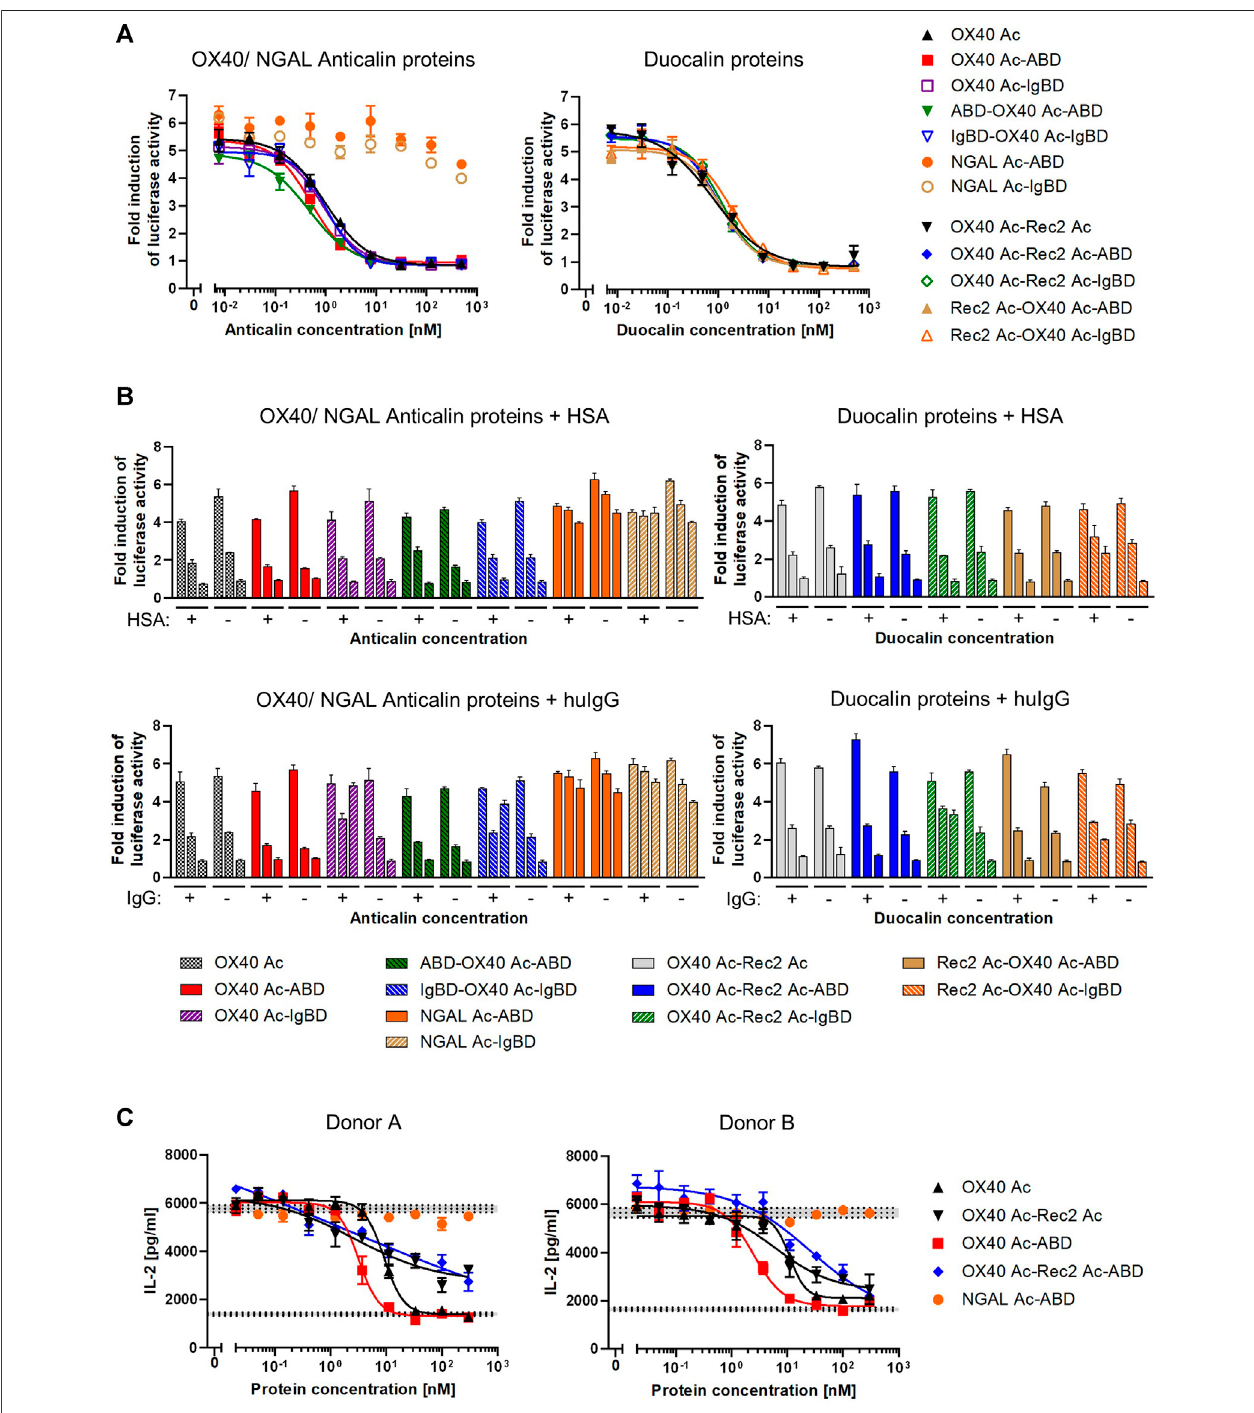
FIGURE4| FunctionalblockingofOX40receptorbyAnticalinproteins invitro . (A) OX40antagonizingAnticalinproteinswereaddedintitrationtoNF κ B-Luc2/OX40 Jurkat reporter cells 30 min before stimulation with 3 nM OX40 ligand. The ligand concentration was previously adjusted to result in aNF κ B-controlled luciferase activity approximately in the range of a half-maximal effect. After 5 h of ligand stimulation, luciferase substrate was added and resulting luminescence was measured. Data is represented as mean ± S.E.M. of triplicate values from one experiment, which is representative of three independent experiments. (B) Luciferase activity was monitoredafteradditionof1.5 µMHSA (uppergraphs) oramixtureofequimolaramountsofhumanIgG1IgG2andIgG4 (lowergraphs) inparallelwiththeAnticalinor Duocalin proteins. Column triplets represent three selected concentrations of Anticalin proteins (from left to right: 0.01, 1.95, 500 nM). Data is represented as mean ± S.E.M.of triplicate values. This data isa representation from three independent experiments. (C) The OX40 receptor blocking activity ofa subset of Anticalin or Duocalin